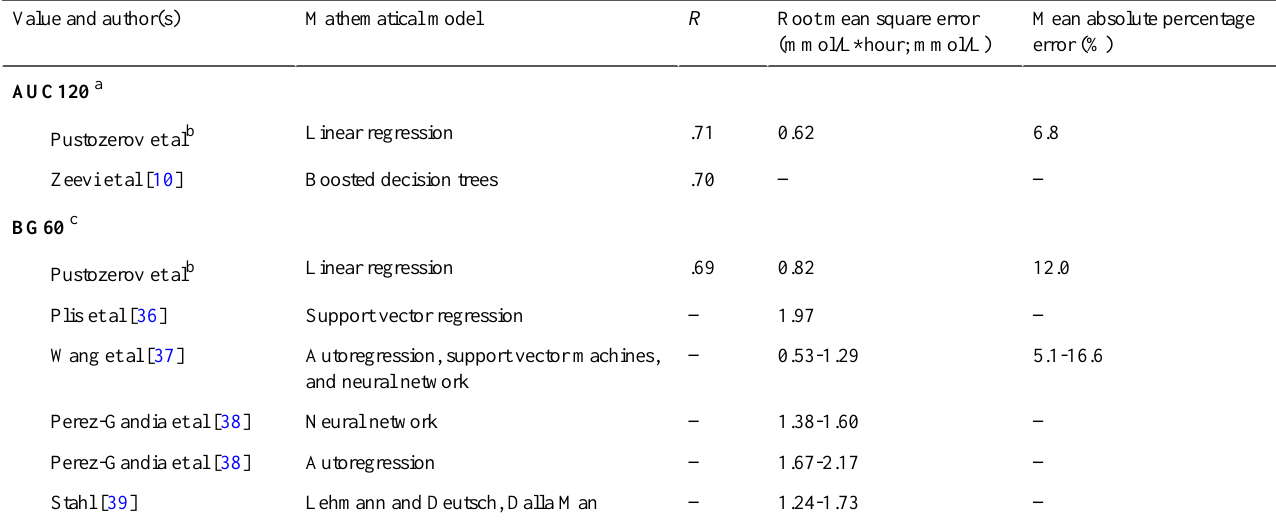
Table 5. Comparison between the proposed model and prior developed